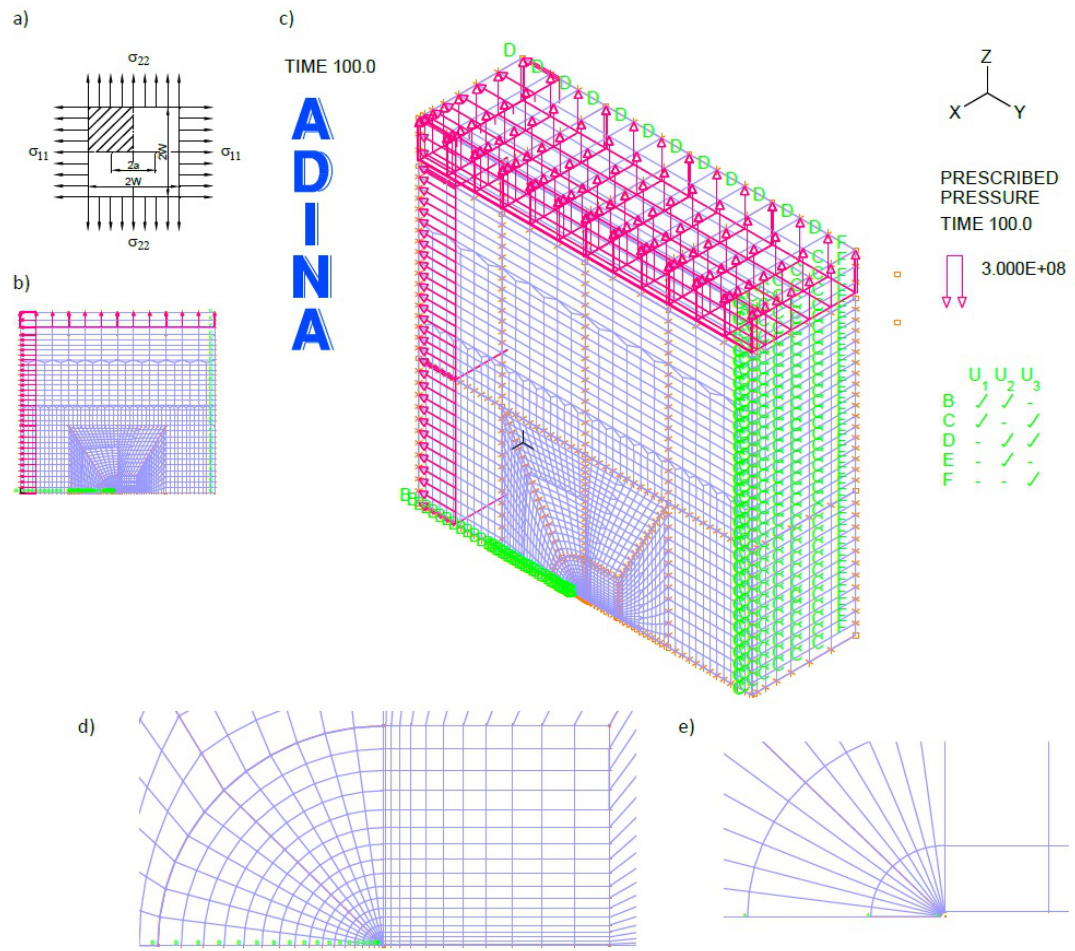
Figure 6: Numerical model of the CCSP(BT) used to calculate the limit loads for the 3D cases: a) specimen fragment modelled in the ADINA program; b) general model; c) view of the specimen with the edge; d) magnified fragment of the mesh near the crack tip; e) crack tip